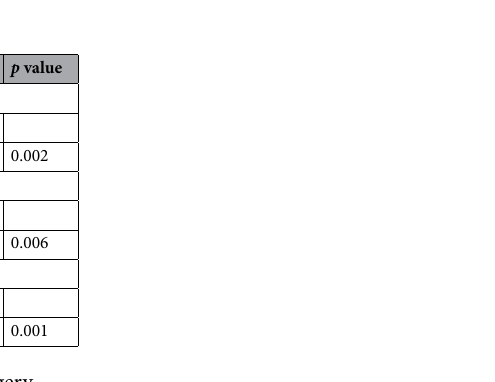
Table 2. Cancer-specific survival following renal